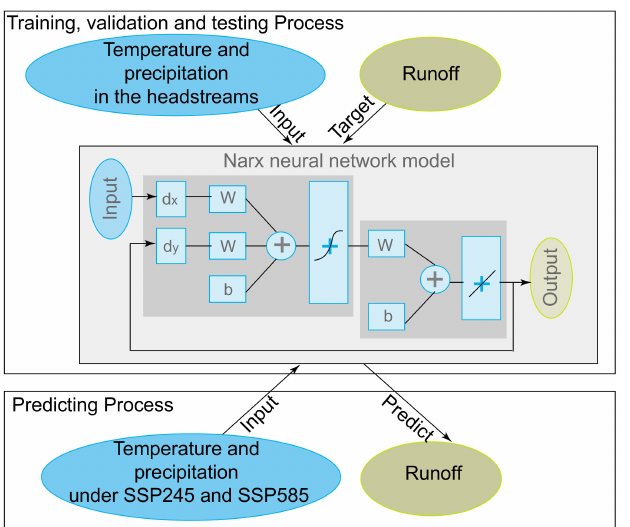
Figure 2. Scheme of the training and application processes of the neural network model. d y and d x are the output and input memory orders, respectively. W and b are the weight and bias,